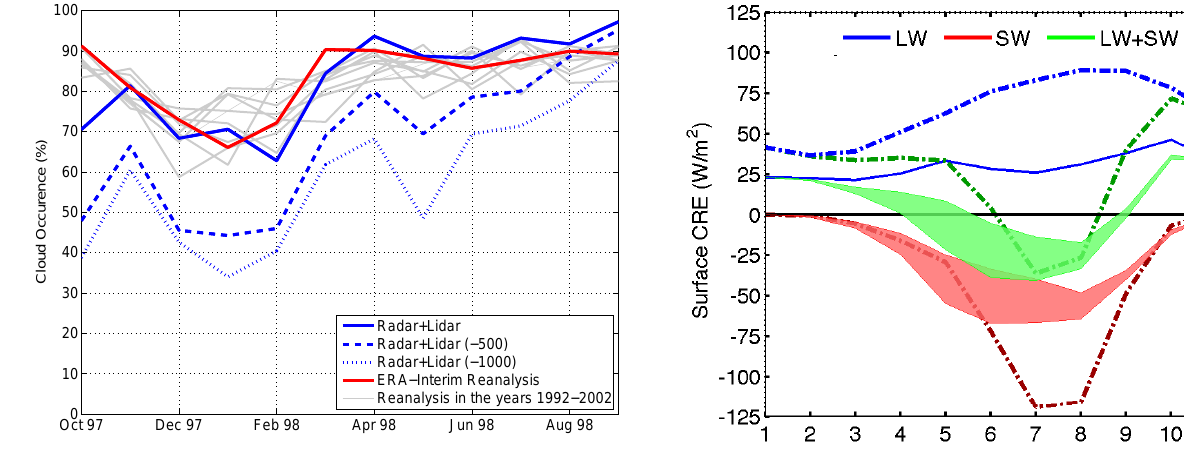
Fig. 4. Total cloud fraction based on combined ground-based lidar and radar observations (blue solid) from the SHEBA field campaign for the period from October 1997 to September 1998, while ERA- Interim total cloud fraction (red solid) is averaged over the blue re- gion shown in Fig. 1, 74–81 ◦ N and 145–170 ◦ W. Dashed and dot- ted blue lines show the total cloud fraction obtained while neglect- ing clouds detected in the lowest 500m and 1000m, respectively. Gray thin lines are ten other individual years from ERA-Interim.